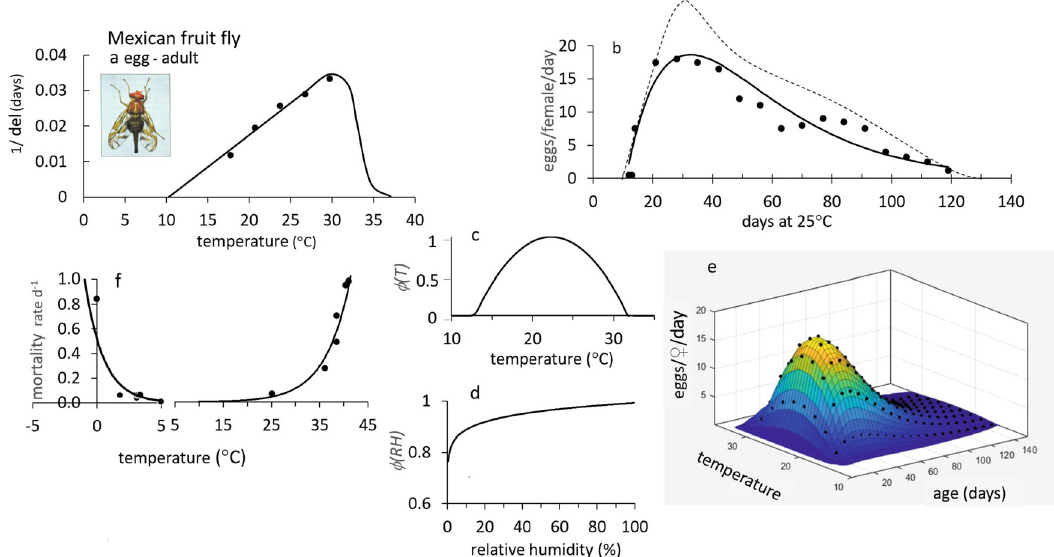
Fig. 8 Biodemographic functions for Mexican fruit fl y. a Rates of development of egg-pupal stages 104 – 108 , b per capita fecundity pro fi le on age in days at 25 °C ( _____ ) 107 and (------) 108 , c , d temperature ( ϕ (T) ) and relative humidity ( ϕ (RH) ) ) scalars for adult reproduction with ϕ (RH) scaled up 36% from that reported for med fl y, e 3-D age speci fi c fecundity pro fi les corrected for the effects of ϕ (T) , and f mortality rates for all life stages. The clip of Mexican fruit fl y is by Jack Kelly Clark, University of California Statewide IPM Program.